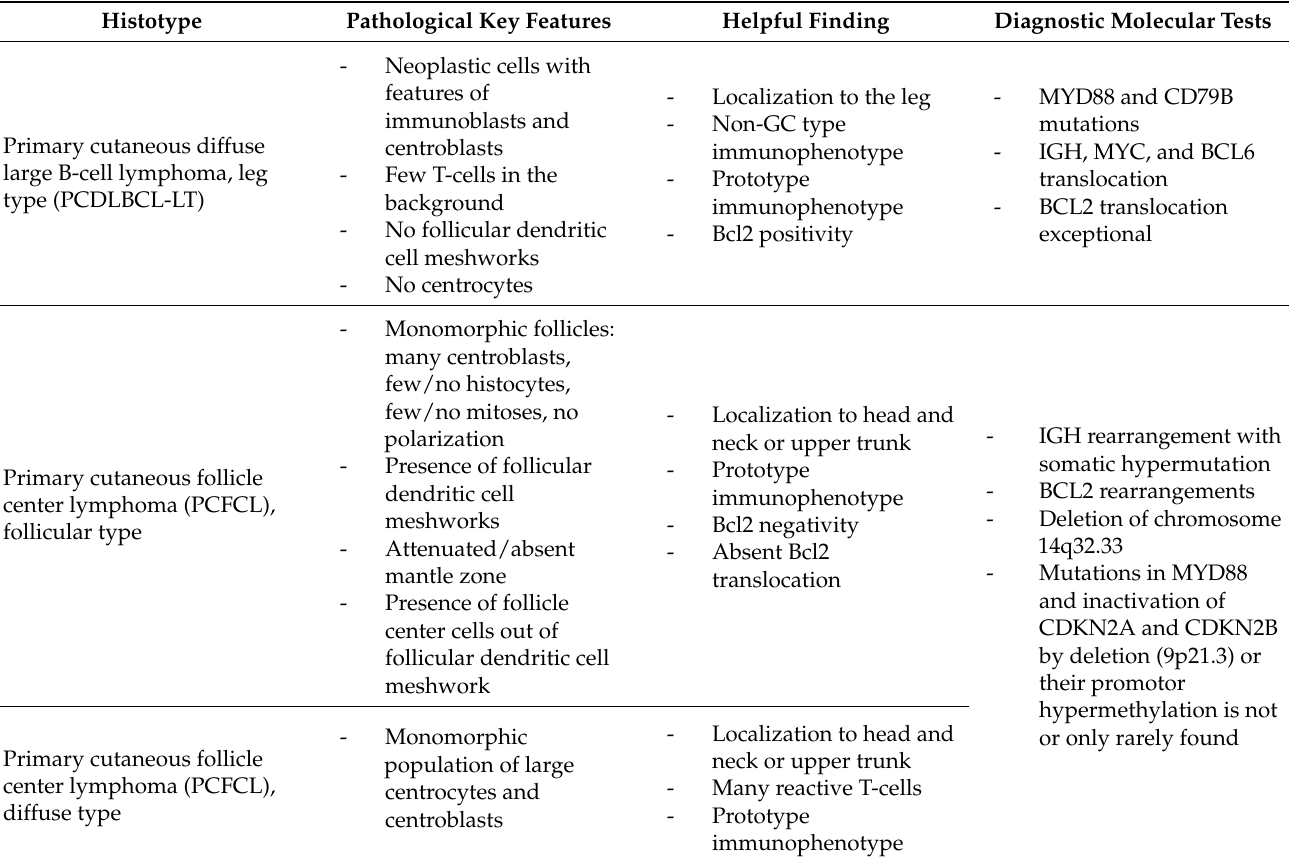
Table 1. Main diagnostic findings of primary cutaneous large B-cell